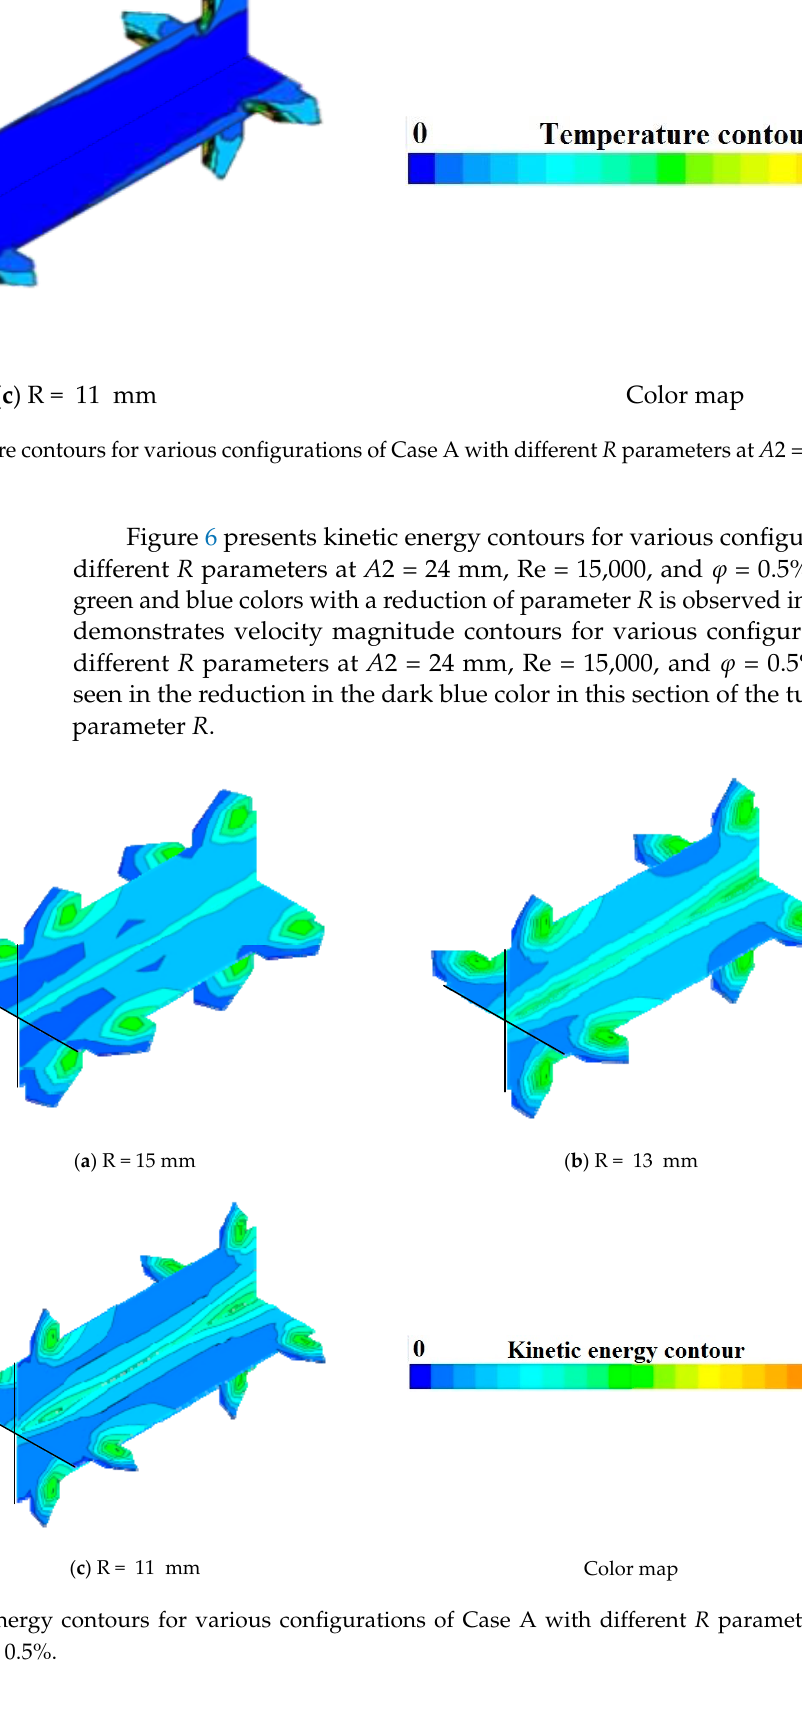
Figure 6. Kinetic energy contours for various configurations of Case A with different R parameters at A 2 = 24 mm, Re = 15,000, and 𝜑 = 0.5%.